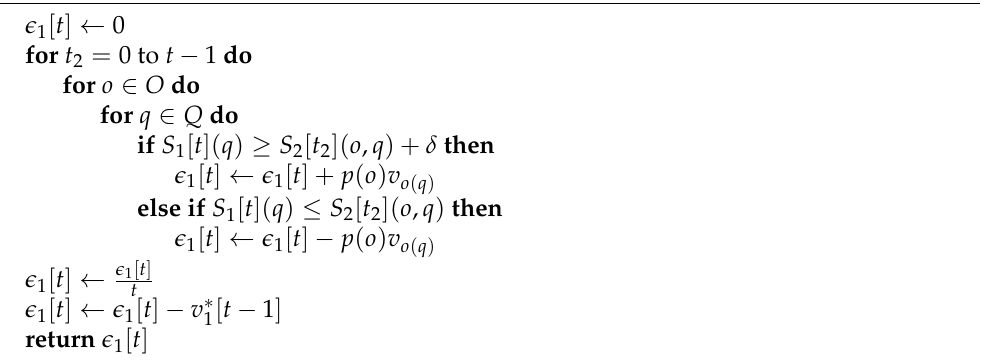
Algorithm 3 Procedure to compute (cid:101) 1 [ t ] in continuous